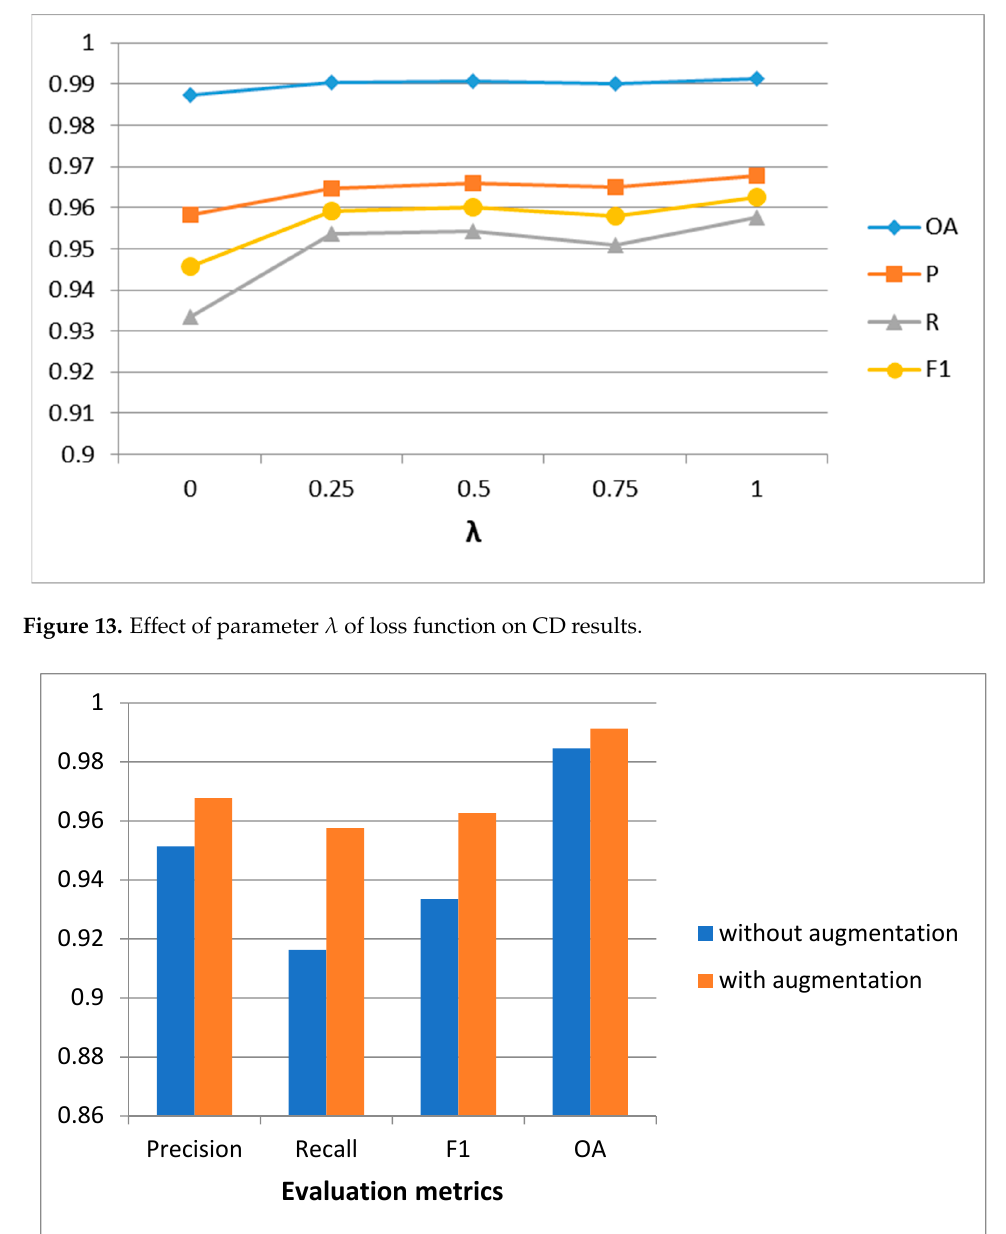
Figure 14. Effect of data augmentation on CD evaluation metrics.